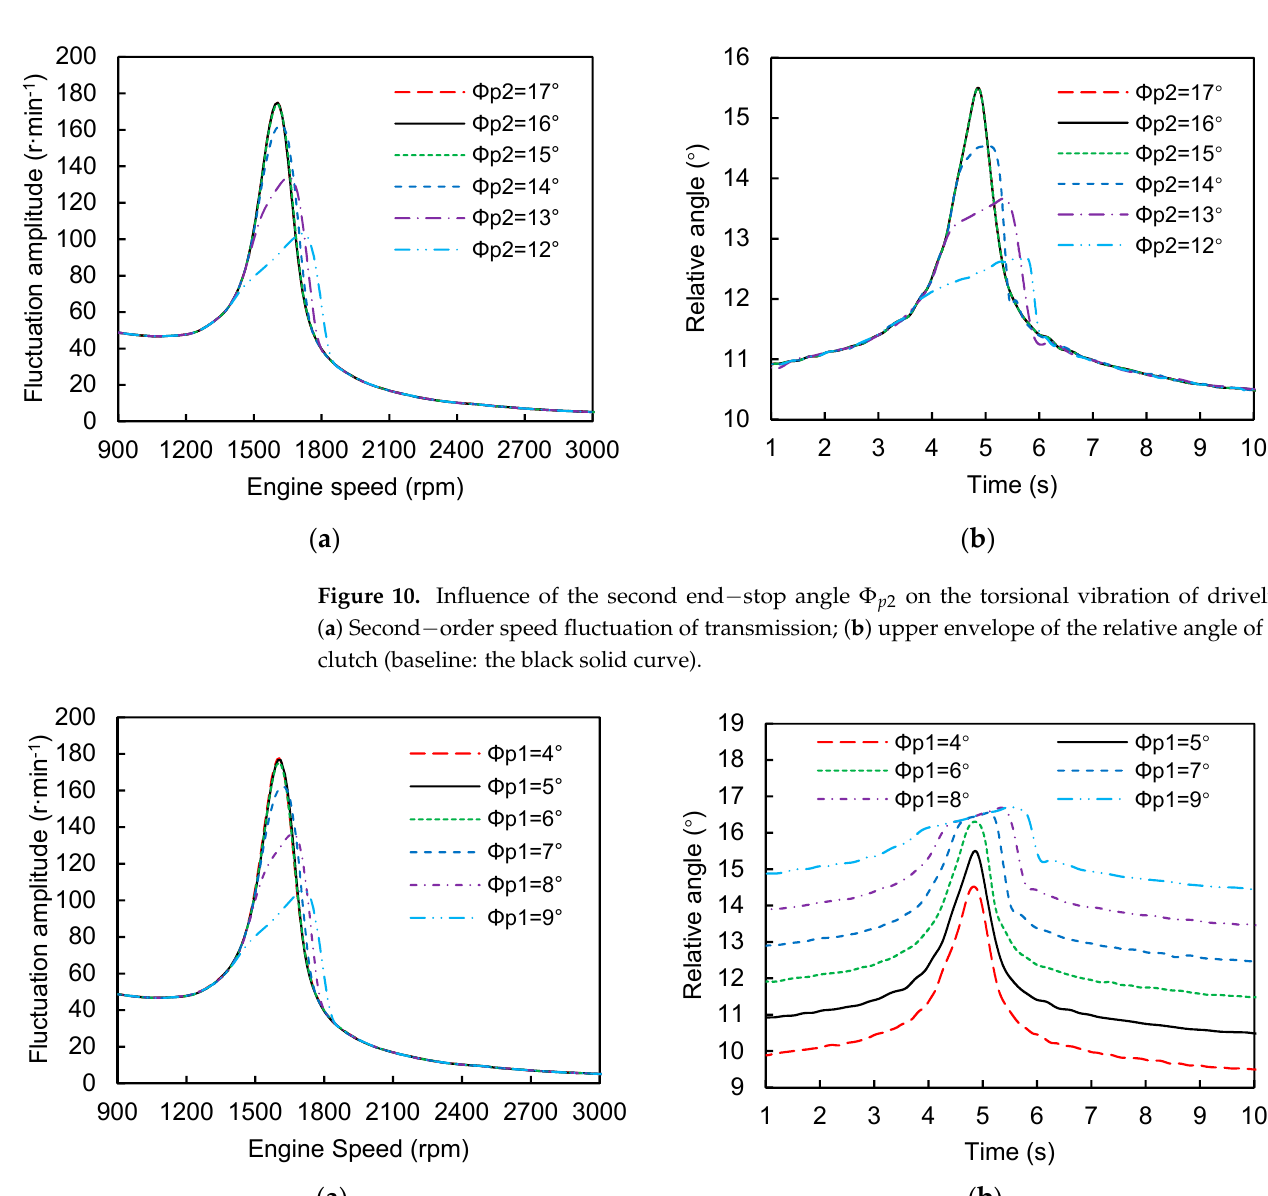
Figure 11. Influence of the first end − stop angle Φ p 1 on the torsional vibration of driveline. ( a ) Second − order speed fluctuation of transmission; ( b ) upper envelope of the relative angle of the clutch (baseline: the black solid